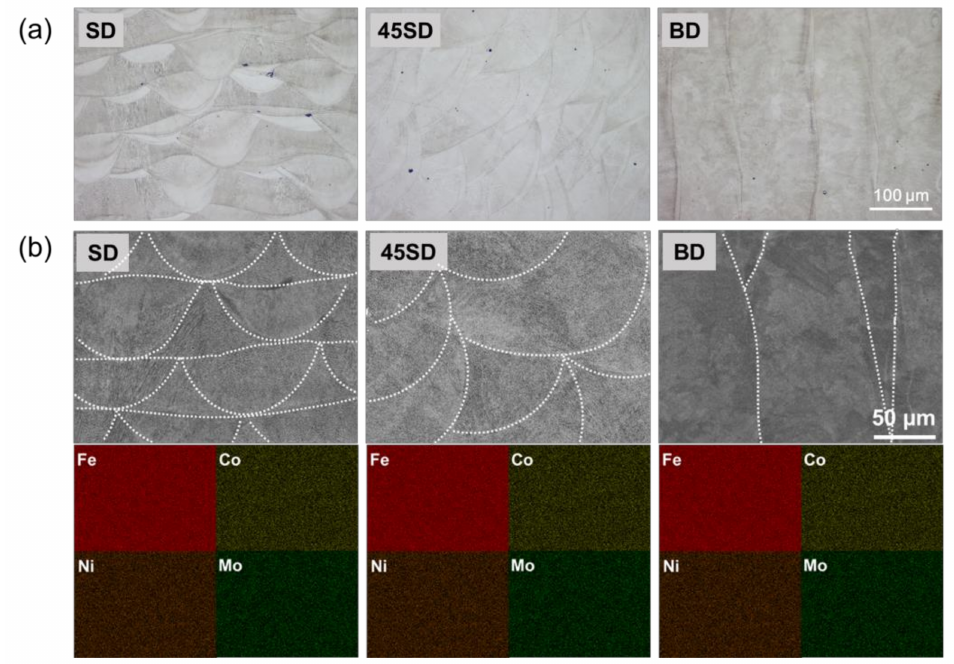
Figure 2. ( a ) OM images ( × 200) and ( b ) SEM images ( × 500) and EDS mappings of the wear plane of each as-built